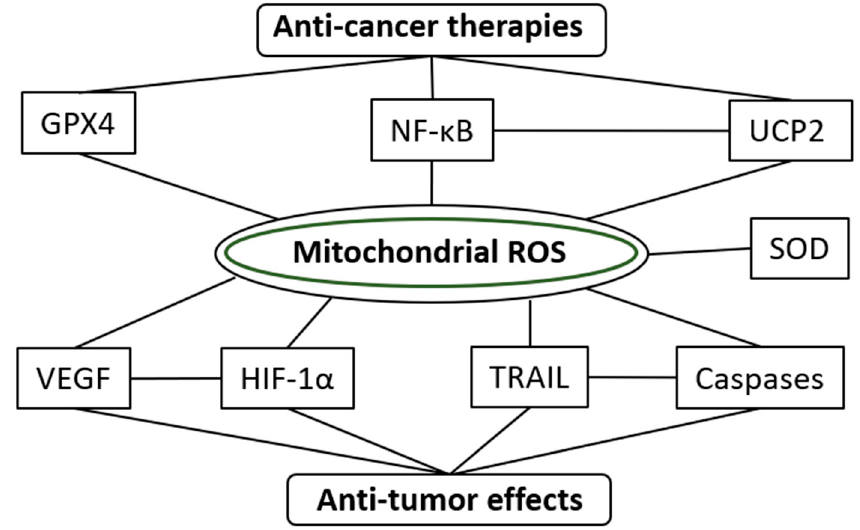
Figure 2. Schema of molecular mechanisms of mitochondrial ROS-related anticancer effects.